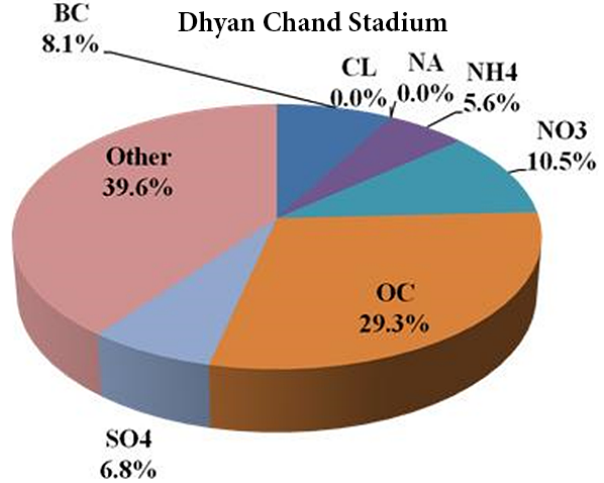
Figure 8. Percent contribution of each species to total PM 2 . 5 at Dhyan Chand